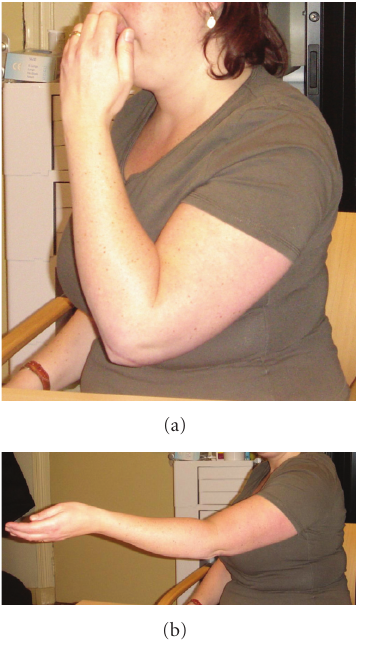
Figure 4: Two years after the index surgery she had a functional elbow with 105 degrees of ulnohumeral motion (115 degrees of flexion (a) and a 10-degree flexion contracture (b)), 87 points according to American Shoulder and Elbow Surgeon evaluation and 7 points on the Disability of Arm Shoulder and Hand